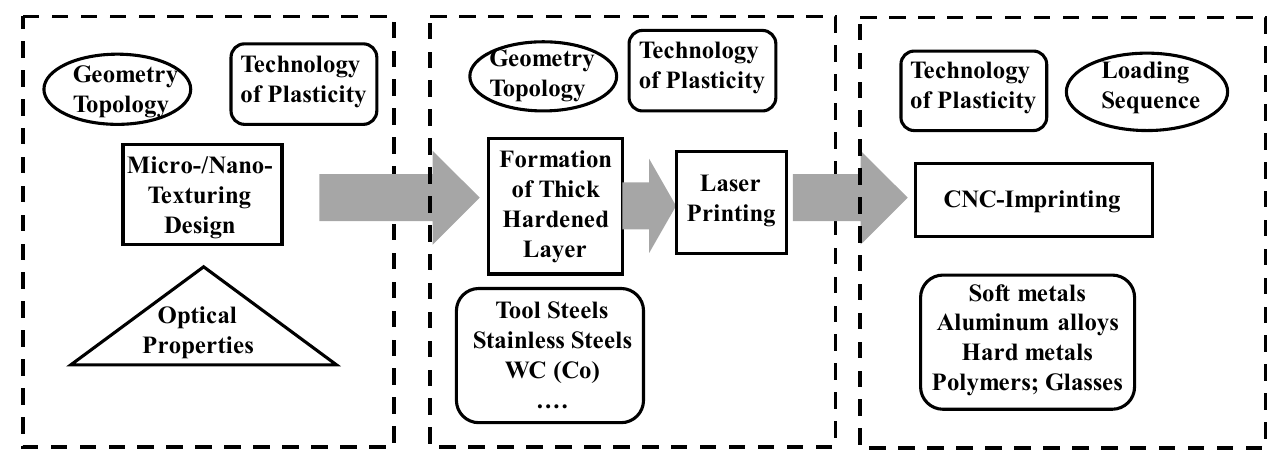
Figure 2. Three-step procedure from the geometric and topological design on the micro-/nano-patterns to its imprinting onto the product surface via tooling.